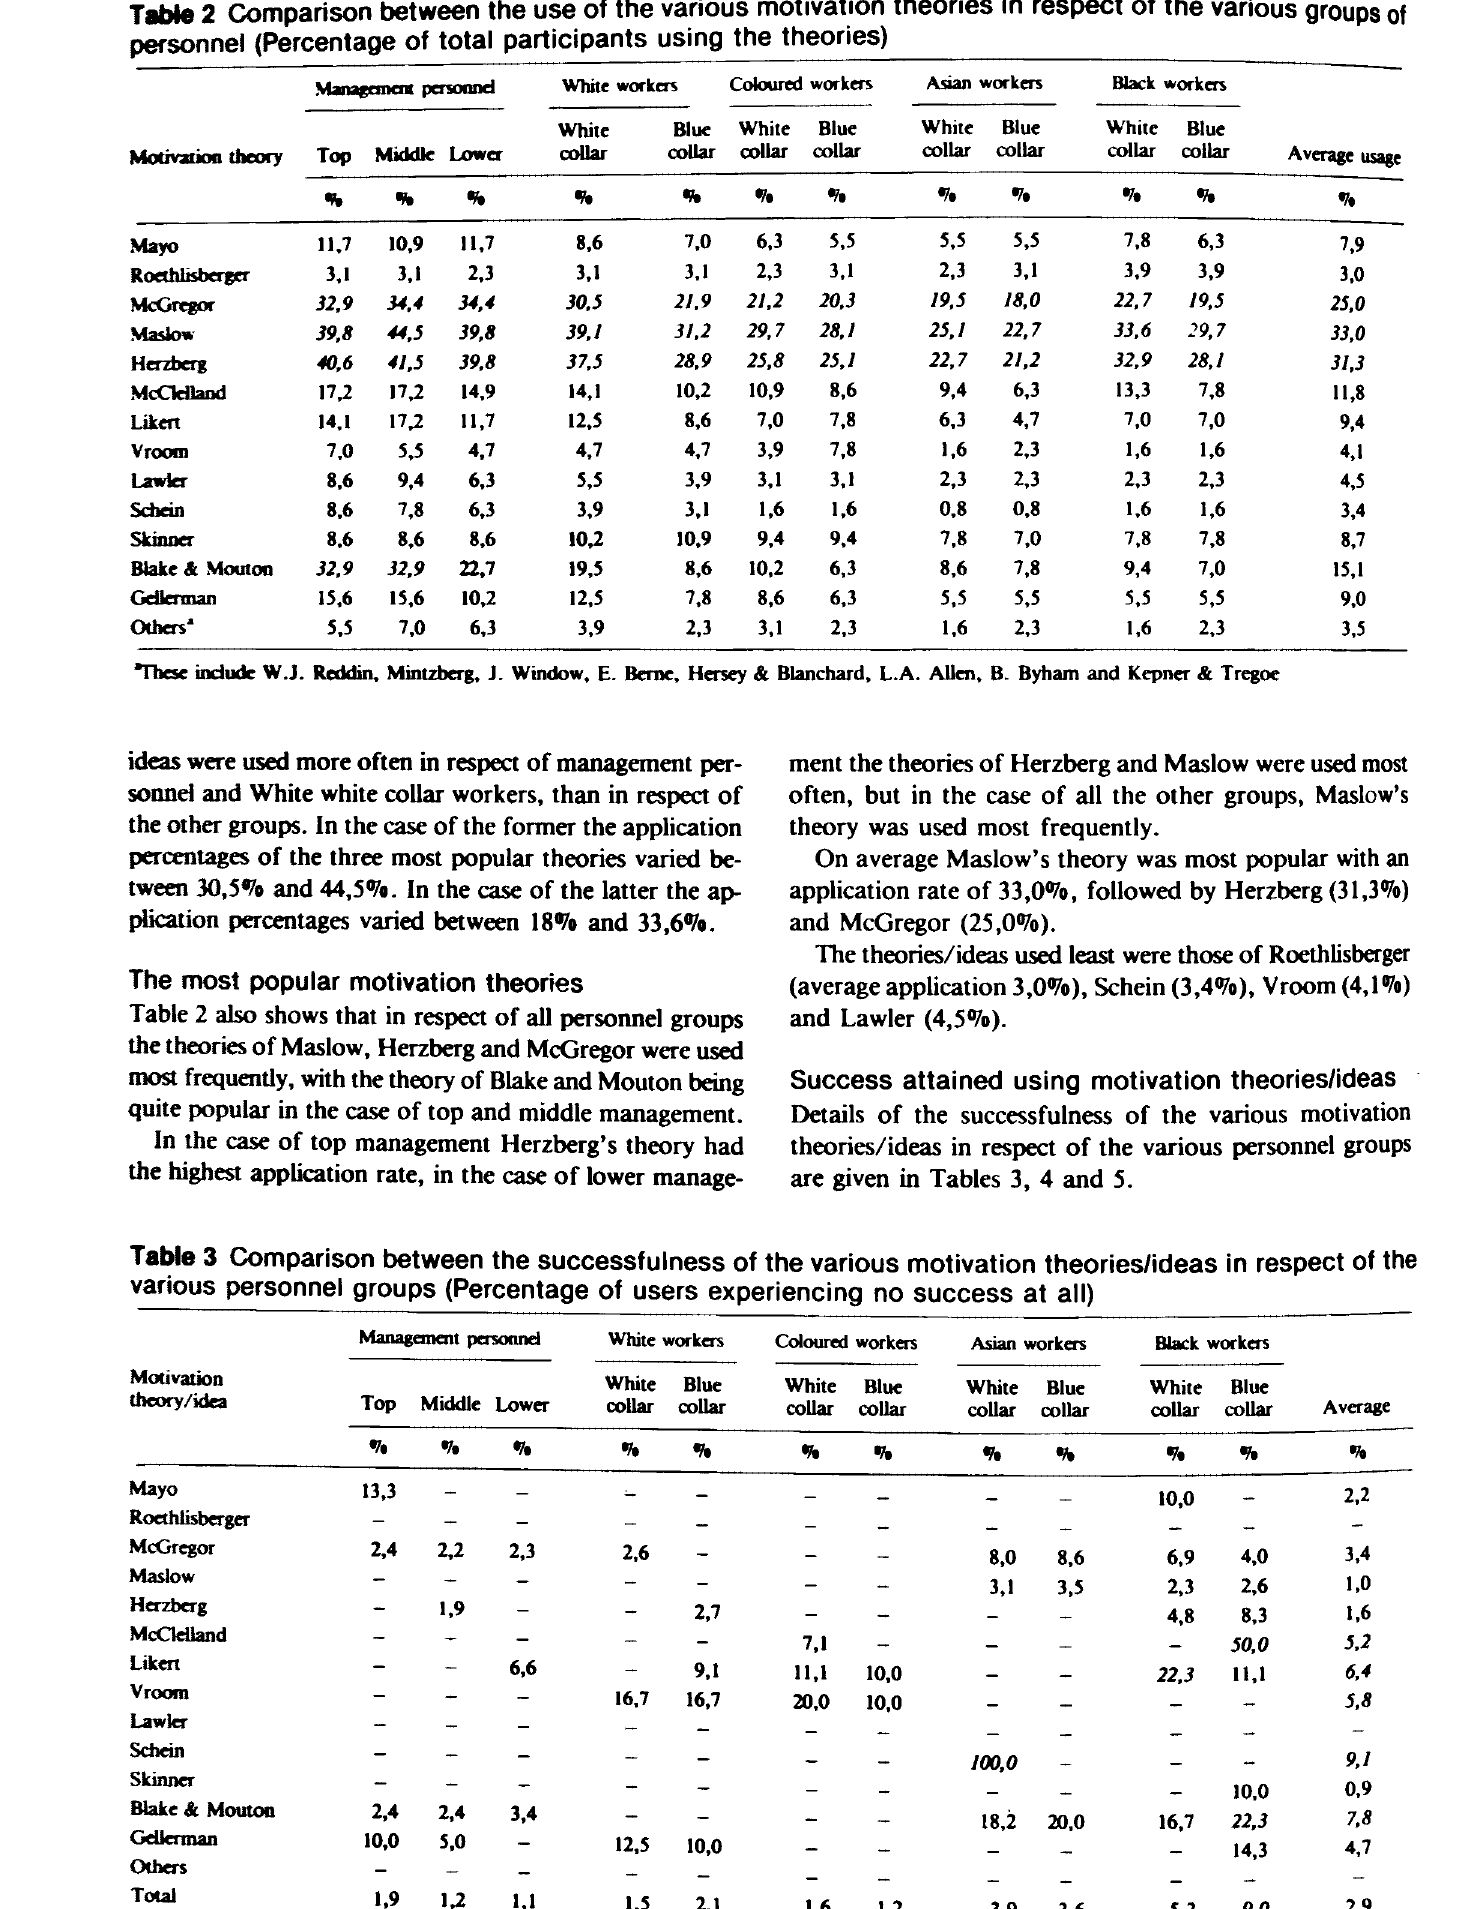
Table 2 Comparison between the use of the various motivat_ion theories in respect of the various groups of personnel (Percentage of total participants using the theories) M....-pcnoond White workers Coloured workers Asian workers Black workers White White